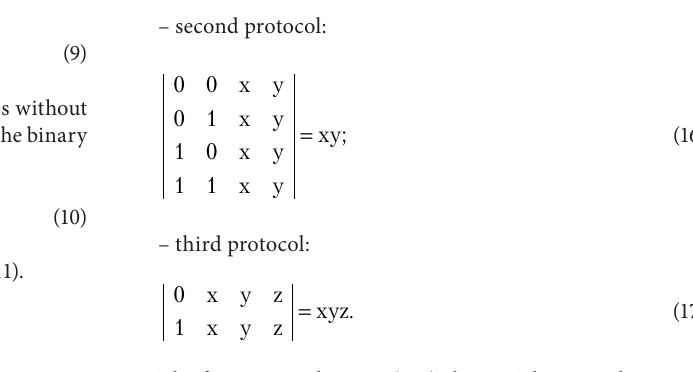
The first protocol uses 2 (3, 8)-design. The second protocol uses 2 (2, 4)-design. The third rule uses 2 (1, 2)-design. The procedure for reducing the total perfect disjunc- tive normal form (PDNF) of the logical function gives